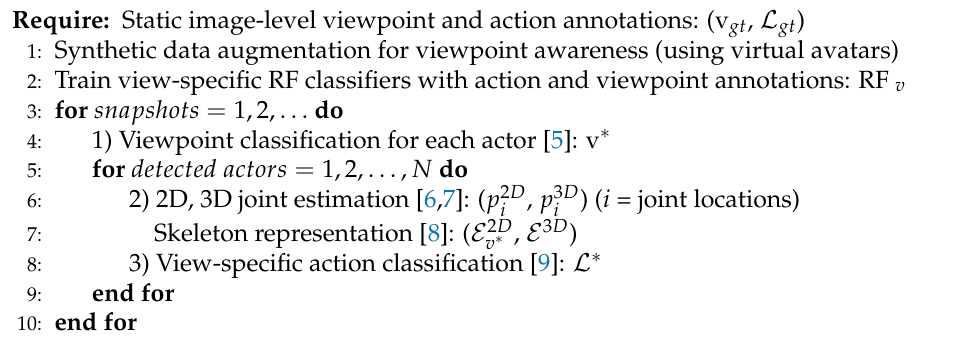
Figure 3. Algorithm overview. Algorithm 1 Still image based